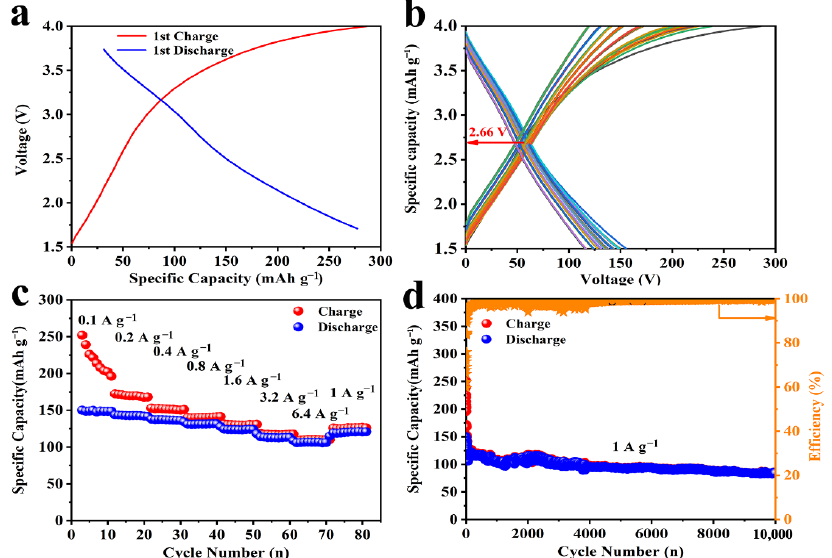
Figure 3. The electrochemical characteristic for sodium ion capacitors with SCDC as cathode and sodium-tin as anode; ( a ) curves of voltage vs. specific capacity for the first charge-discharge; ( b ) the gradient performance obtained from 0.1 to 6.4 A g − 1 increasing by 2 times and circulates 10 laps for each current density; ( c ) the cyclic performance at 1 A g − 1 ; ( d ) curves of voltage vs. specific capacity for the first 100 cycles of ( c ).